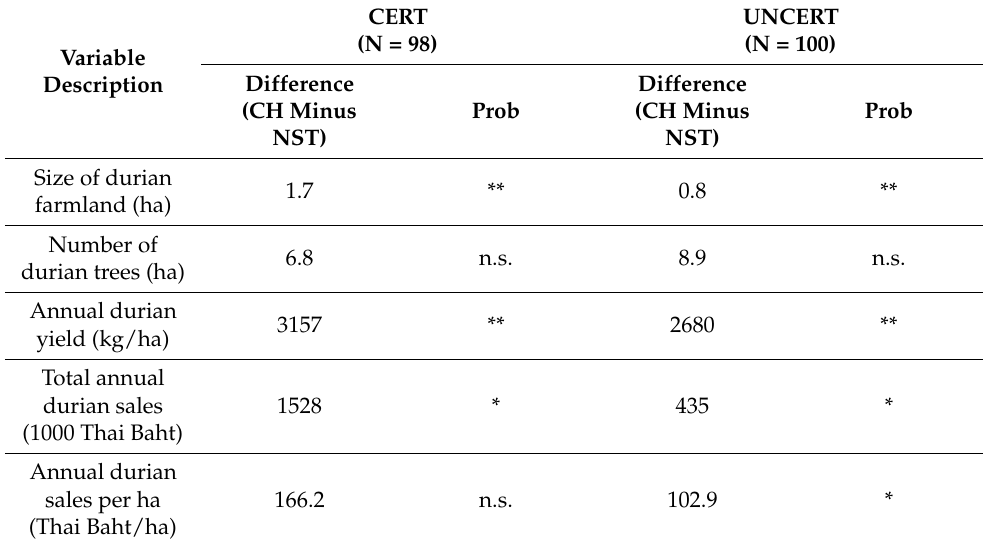
Table A3. Regional difference in the respondents’ durian production by farmer type.